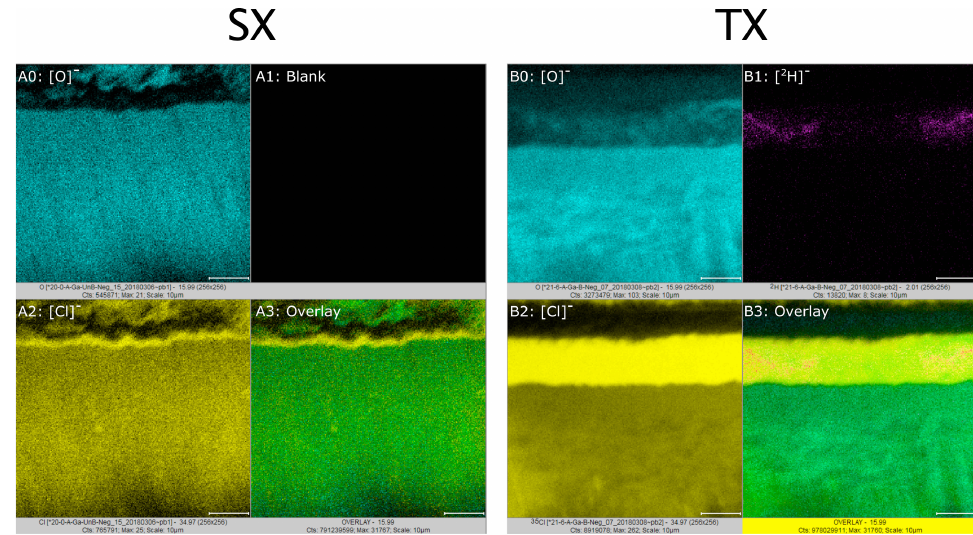
Figure 10. ToF-SIMS maps [O] − , [ 2 H] − , and [Cl] − and overlay. SX : activated by direct HCl gas exposure with the “double-HCl” process. TX : activated by gas from pyrolysis of 15 N 2 H 4